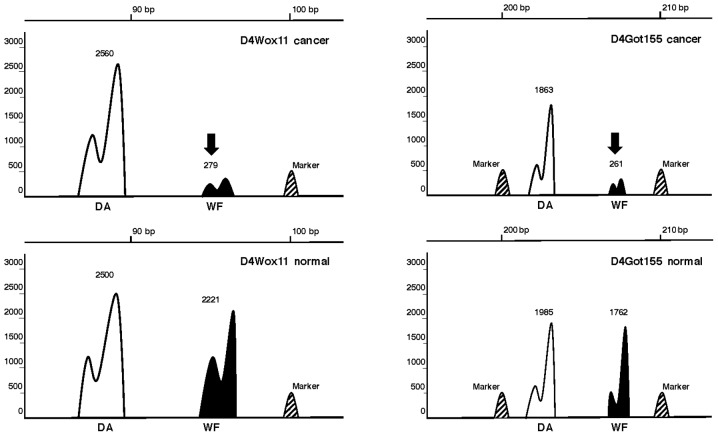
Representative LOH data analysis at microsatellite loci D4Wox11 (Pthlh) (left) and D4Got155 (right). The upper panels show the peak heights in arbitrary units of the WF (filled) and DA (unfilled) alleles from a TC in a (DA × WF) F1 rat, and the lower panels show those from the normal tongue tissue of the same rat. LOH, loss of heterozygosity; WF, Wistar-Furth rat; DA, Dark Agouti rat.